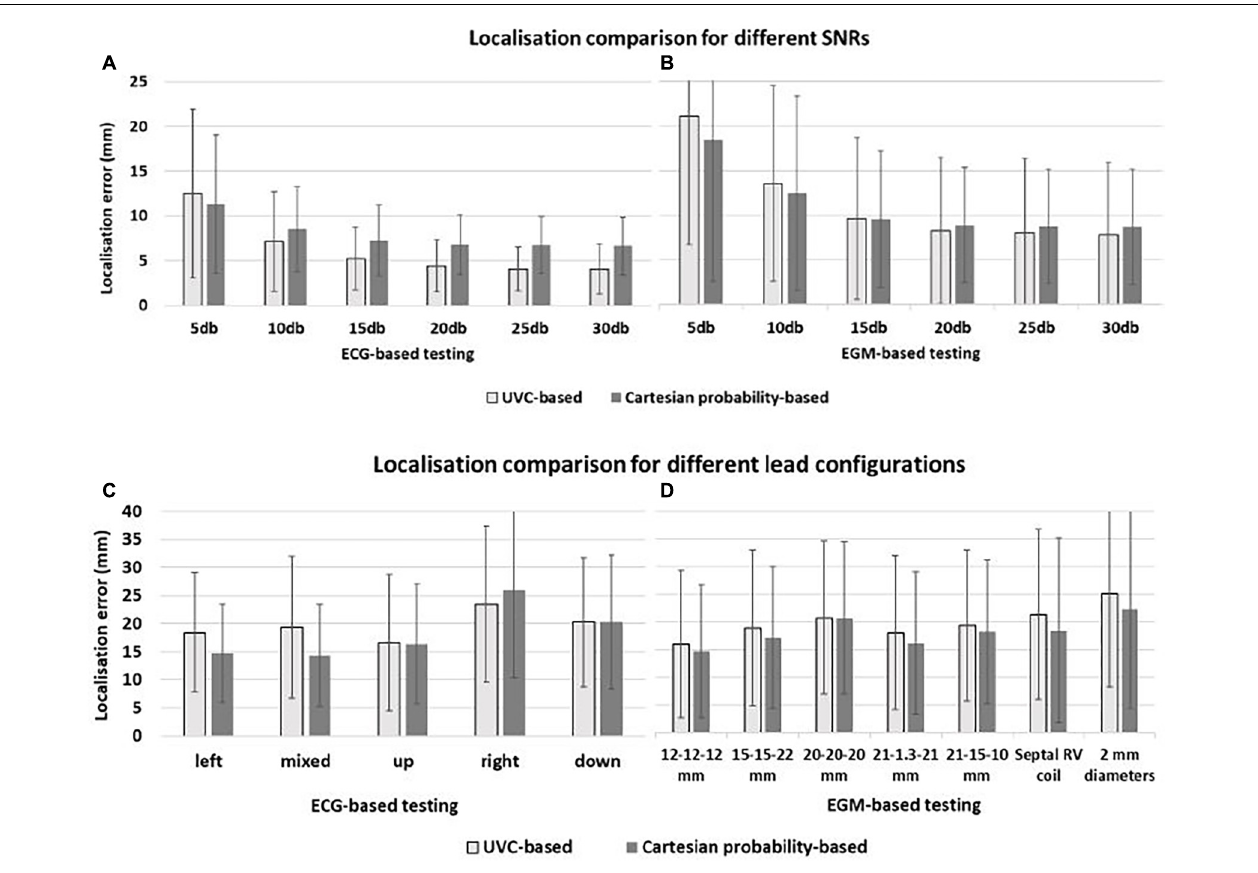
FIGURE 12 | Localization comparison between UVC-based (light gray) and Cartesian probability-based (dark gray) networks. Localization performance for ECG-based and EGM-based testing are here reported during sensitivity analysis for different noise levels— (A,B) , respectively—and for different lead configurations— (C,D) , respectively. For all panels, mean errors with corresponding standard deviations are reported for UVC-based (light gray) and Cartesian probability-based (dark gray) localization. Displacements of ECG leads, shown in Figure 7 , results in localization errors in (C) ; on the other hand, different CIED configurations, shown in Figure 8 , return errors in (D) . Little difference in localization is present between the two networks with similar mean localization